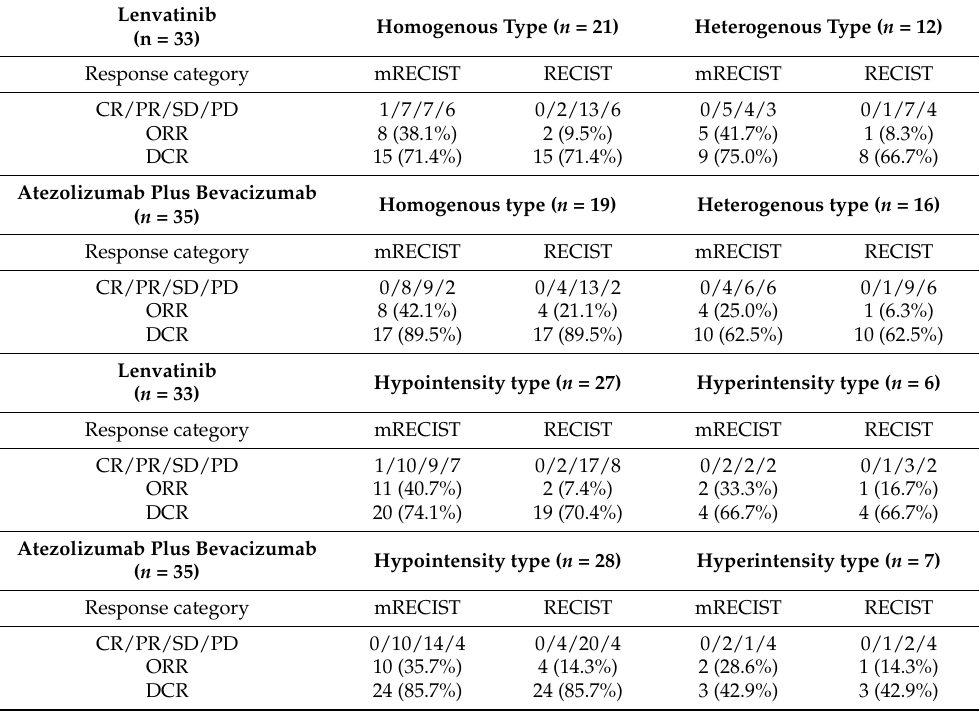
Table 3. Response rates stratified by assessment of EOB-MRI hepatobiliary phase.